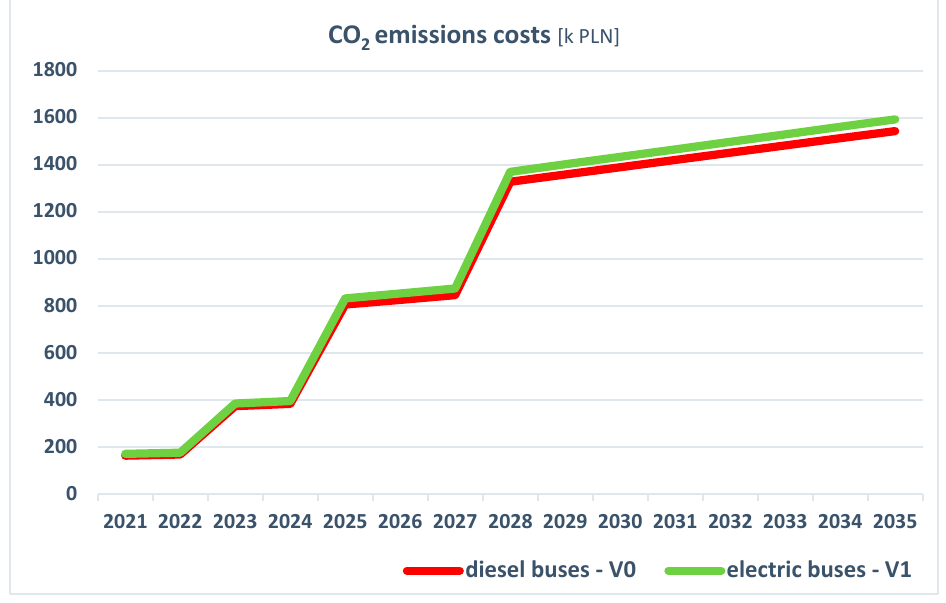
Figure 9. Projected amounts of noise emissions costs of the public bus fleet in Szczecin in the 2021– 2035 period for variants V0 and V1. Table 6. Costs of NHMC/NMVOC, NOx, PM, SO 2 , CO 2 and noise emissions for: V0, V1 and V1 − V0. NMHC/NMVOC